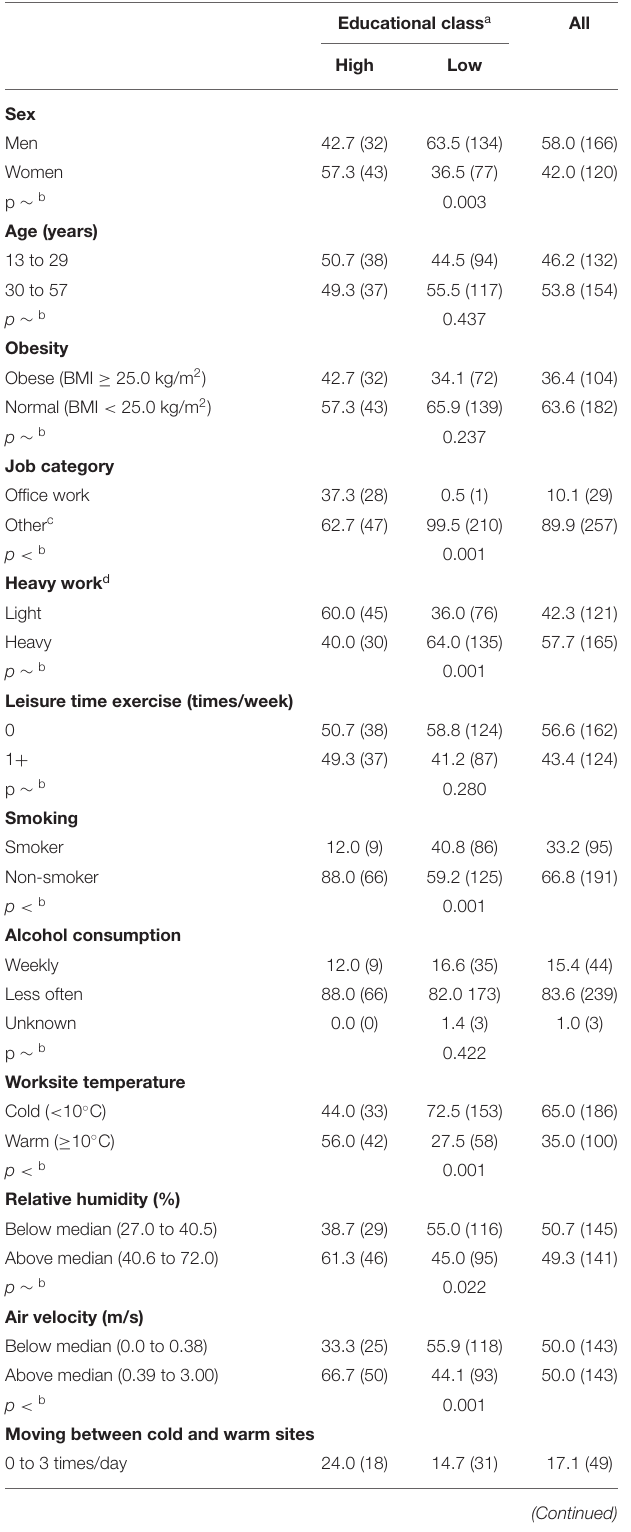
TABLE 1 | Percentages (numbers) of participants according to personal characteristics and workplace environmental conditions: high- and low-educated workers